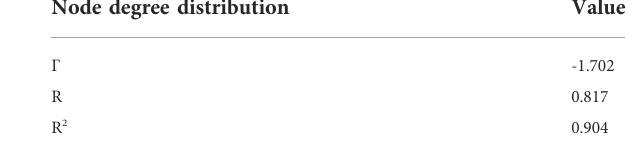
TABLE 3 Node degree distribution in MiRNome_MC. The node degree distribution represents the probability that a selected nodes has k links ( γ = exponent of node degree equation; R 2 = coef fi cient of determination of node degree vs. number of nodes, on logarithmized